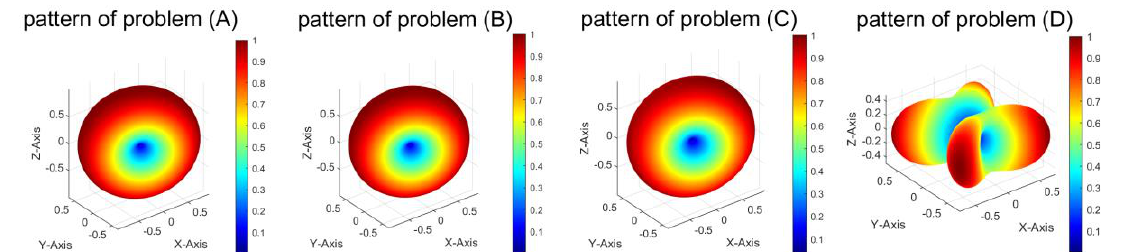
Figure 15. Normalized characteristic patterns of the modes resonant near 2.95 GHz for four different problems at 2.0 GHz.